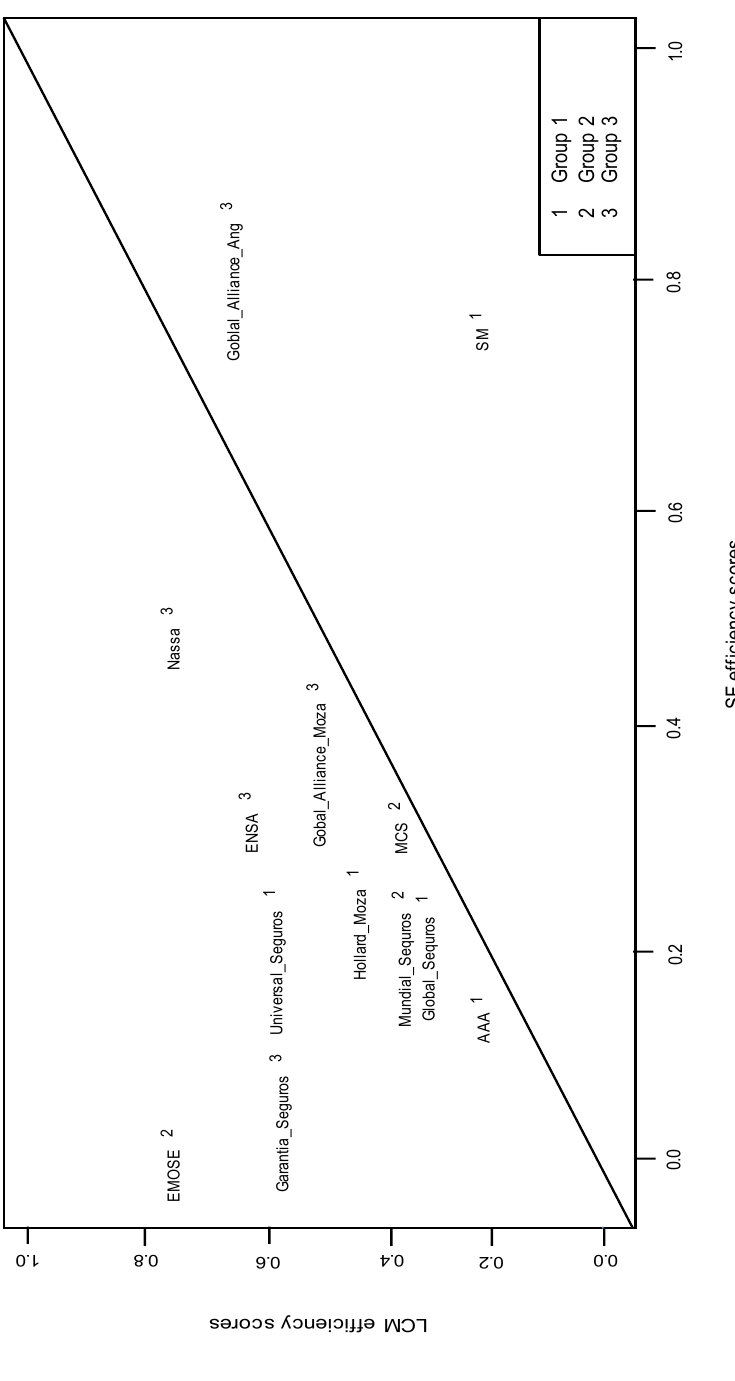
Efficiency score means for each model - group